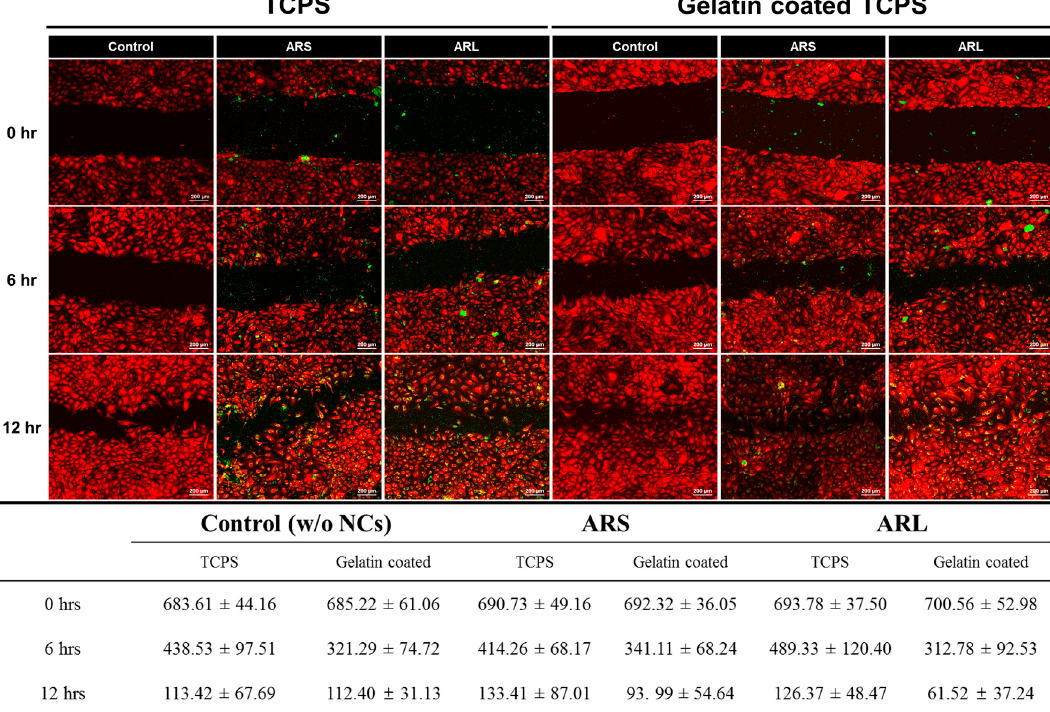
Figure 2. Analysis of HUVECs migration by in vitro scratch assay. Images were acquired at 0, 6, and 12 h post scratch generation. The degree of migration was determined by quantifying the number of cells migrated to the center of scratch. (Red: RFP HUVECs; Green: Alexa Fluor 647 tagged NCs).